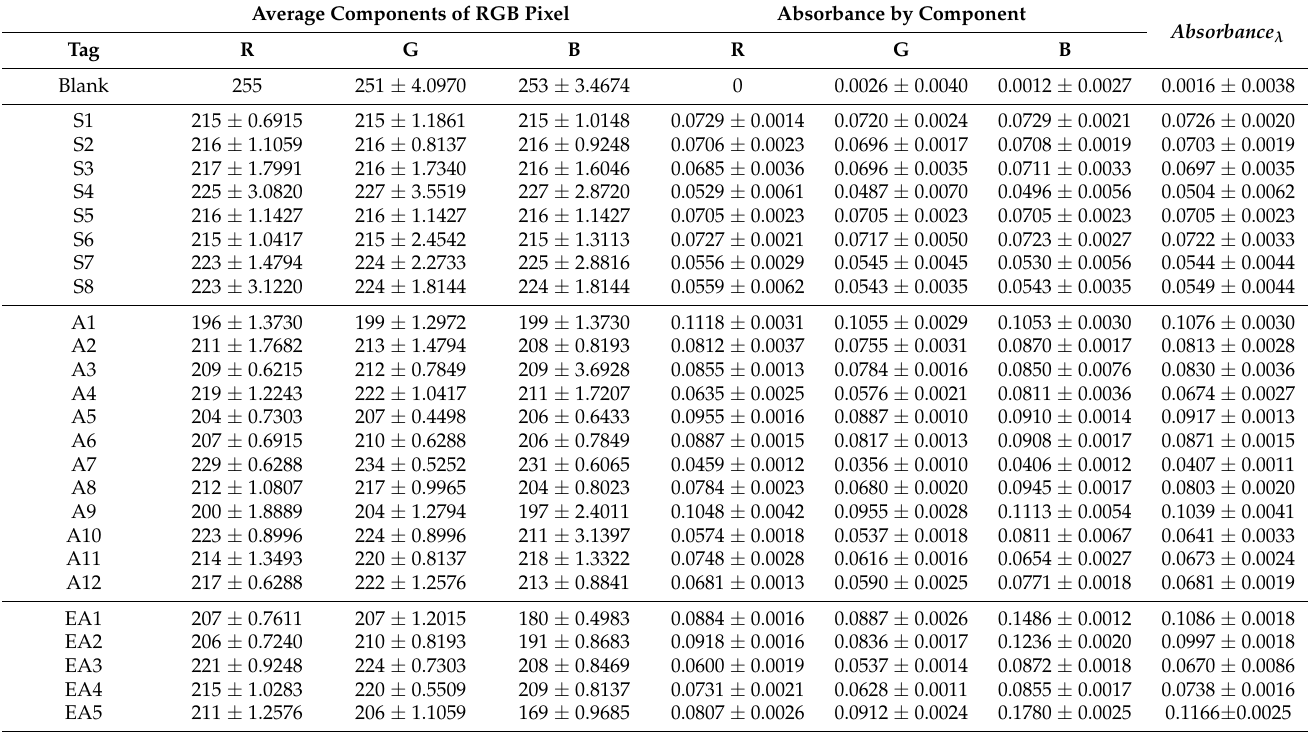
Table 2. Electronic Eye RGB component’s intensities and absorbances values for tequila samples. Furthermore, total absorbance values are